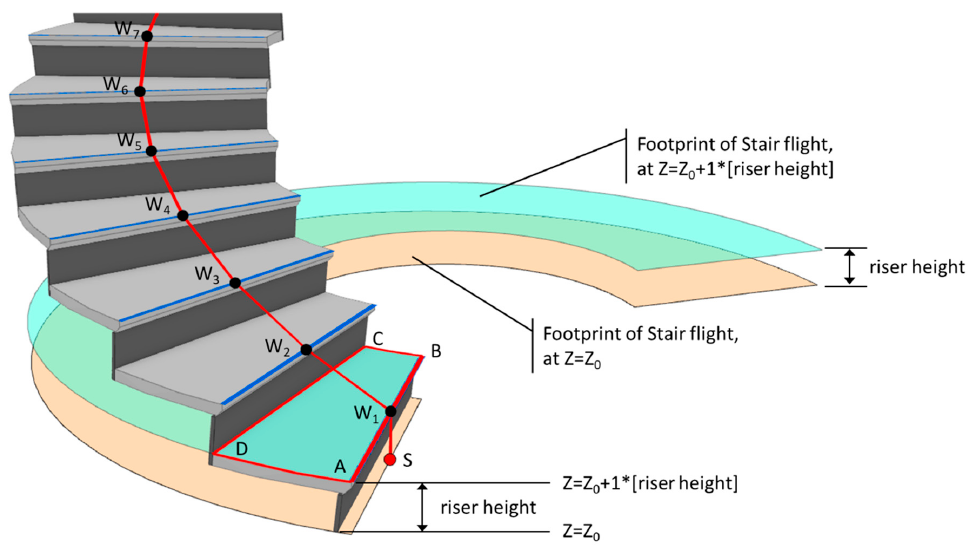
Figure 13. Illustration of the method for determining the path start and waypoints.